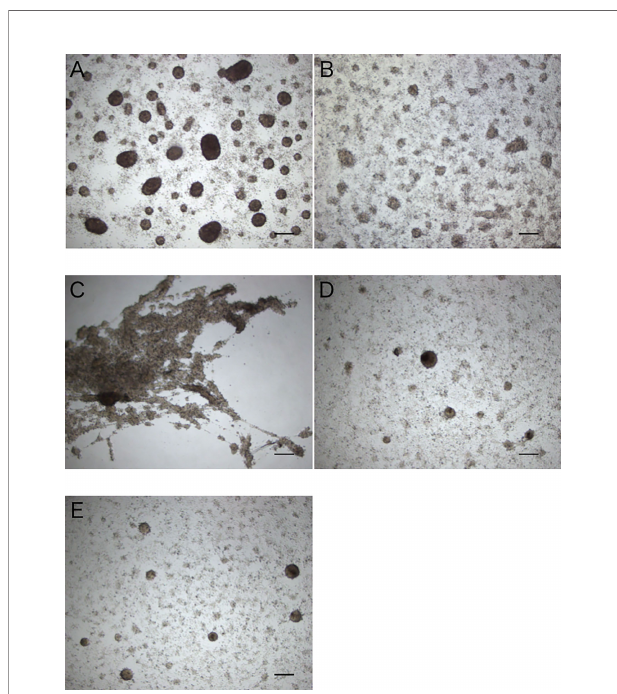
FIGURE 5 | Aggregation-promoting activity of the treated extracts of the intestine. (A) untreated extract. (B) heat-treated extract. (C, D) >5 kDa and <5 kDa fractions of the extract separated by ultra fi ltration. (E) control (coelomic fl uid only). Scale bars = 200 m m.